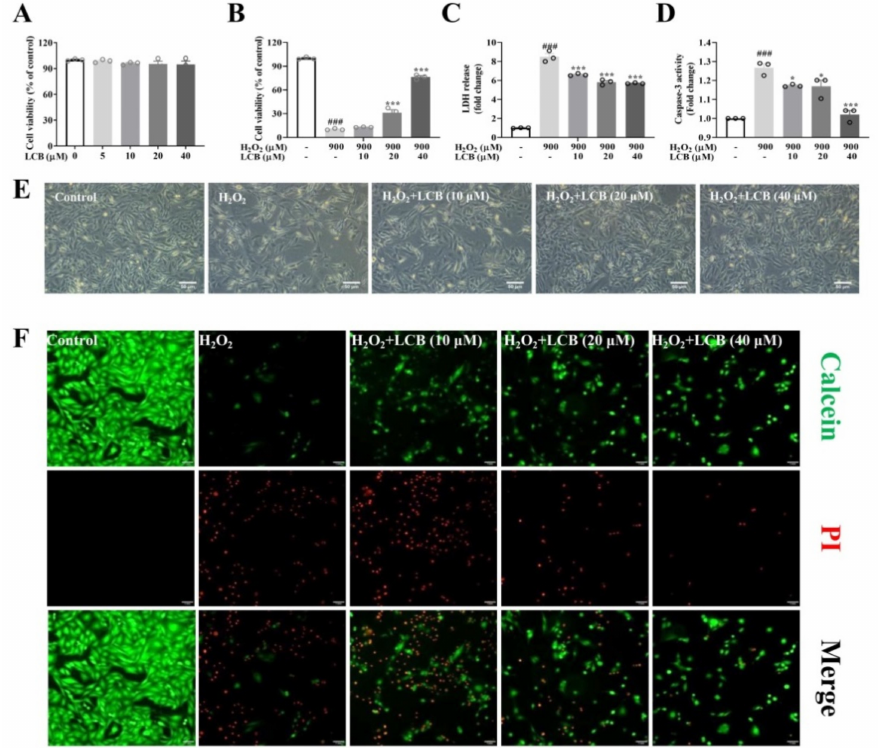
Figure 2. LCB attenuated H 2 O 2 -induced cellular oxidative damage in PC-12 cells. ( A ) The cell viability of PC-12 cells treated with 0 to 40 µ M of LCB for 24 h was measured by the MTT assay. ( B ) Cell viability, ( C ) LDH level, and ( D ) Caspase–3 activity were measured in H 2 O 2 (900 µ M)-induced PC-12 cells for 6 h after LCB (10, 20, or 40 µ M) pre-treatment for 16 h. ### p < 0.001, H 2 O 2 group vs. control; * p < 0.05, *** p < 0.001, H 2 O 2 + LCB group vs. H 2 O 2 group. ( E ) Cellular morphological changes were evaluated in H 2 O 2 (900 µ M) -induced PC-12 cells for 6 h after pretreatment of LCB for 16 h as indicated. Scale bar = 50 µ m. ( F ) Calcein/PI assay was adopted to perform the ICC staining in H 2 O 2 (900 µ M)-induced PC-12 cells for 6 h after pretreatment of LCB for 16 h as indicated. Scale bar = 50 µ